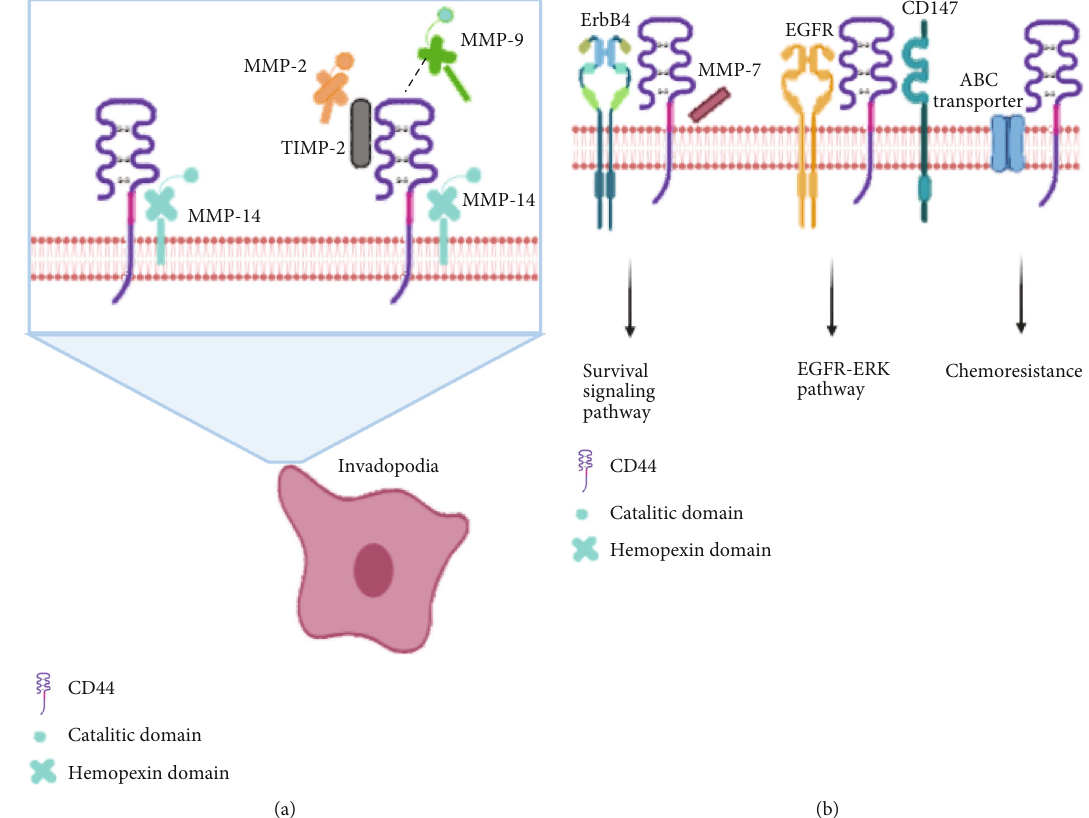
Figure 2: CD44 and interaction with soluble and/or cell membrane ligands. (a) The interaction between CD44 and MMPs directs the latter to the cell front of migrating cells, the so-called invadopodia, simplifying the degradation of substrates present in the extracellular matrix. (b) CD44 interacts and forms complexes with proteins expressed on the cell surface such as the enzyme Erb-B2 receptor tyrosine kinase, epidermal growth factor receptor, or ABC transporter all of which stimulate signaling pathways that promote survival, proliferation, or